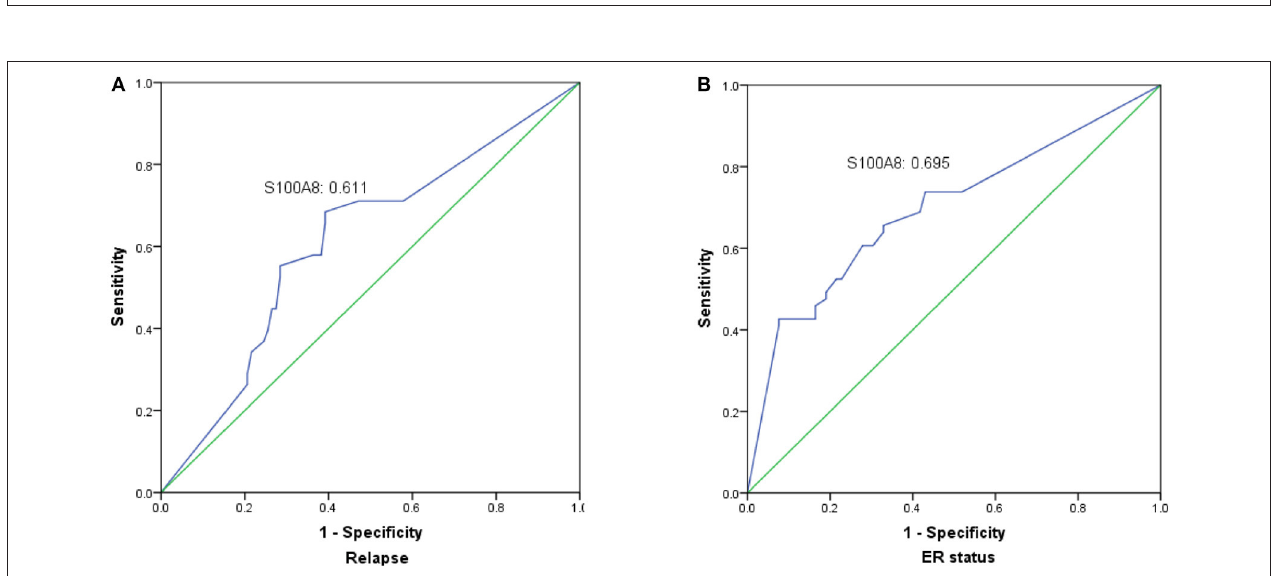
FIGURE 5 | The significance of S100A8 expression was analyzed by establishing an ROC curve in breast cancer. The curve illuminated that elevated S100A8 expression could indicate the possibility of relapse (A) and ER status (B) in breast cancer patients.